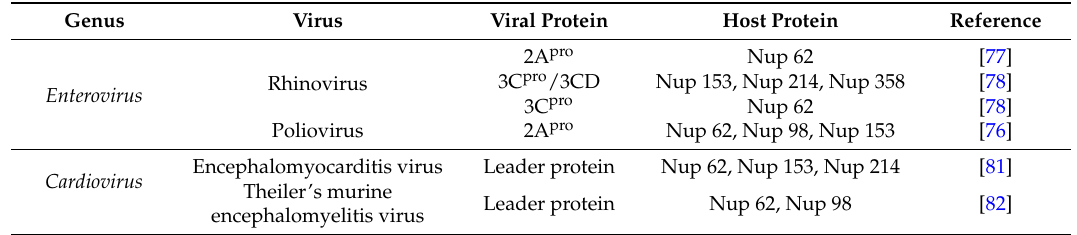
Figure 5. Alteration of the nuclear pore complex induced by 3C pro [72,79,80]. ( A ) The nuclear pore complex is composed by the outer ring Nups, the linker ring Nups, the inner ring Nups, cytoplasmic phenylalanine-glycine (FG)-Nups, nuclear FG-Nups and the nuclear basket; ( B ) The 3C pro of RV can induce cleavage of Nup 153 and Nup 214 and Nup 358. Table 3. Picornavirus -induced alterations to the nuclear pore complex.